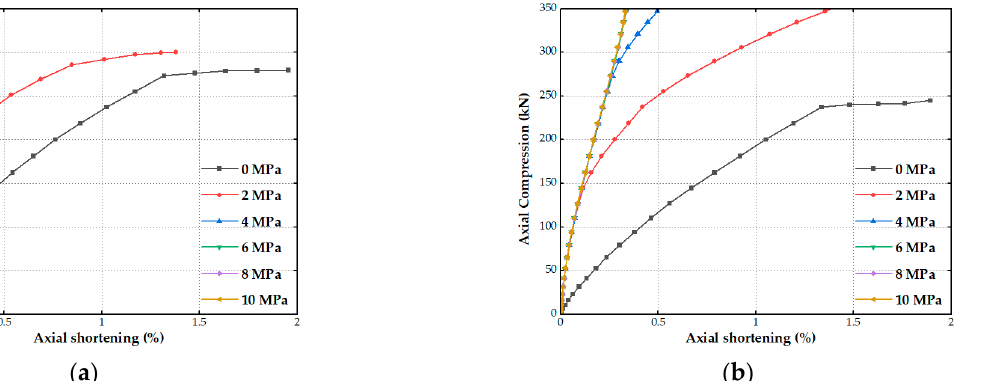
Figure 14. Axial compression-shortening curves with different external pressure: ( a ) steel armored pipe; ( b ) carbon-fiber-reinforced composite materials armored pipe.